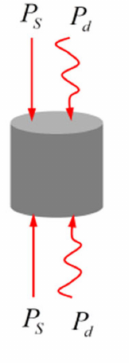
Figure 3. Schematic diagram of static and dynamic combination.